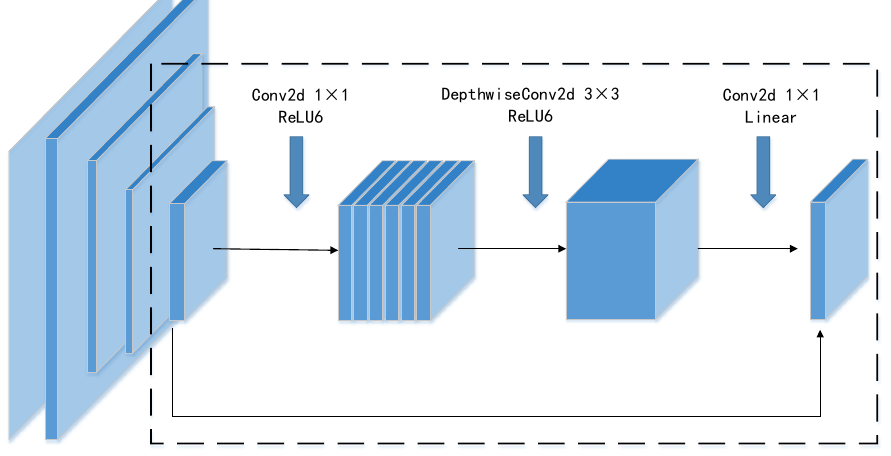
Figure 2. The network structure of Invered_Res_block.